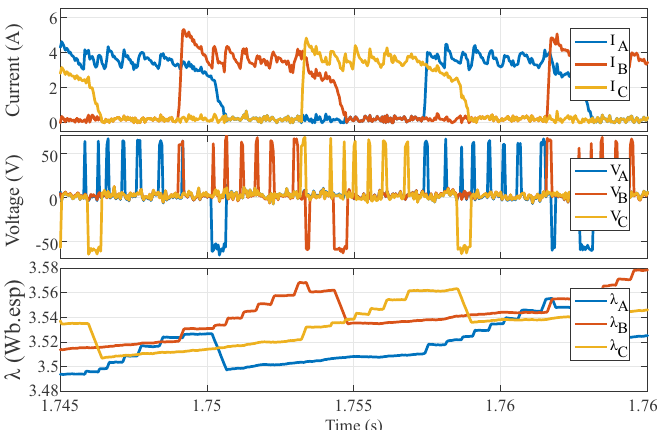
Figure 3. Simulated sensed phase currents, voltages, and estimated flux linkages of a three-phase SRM with noise and calibration offset